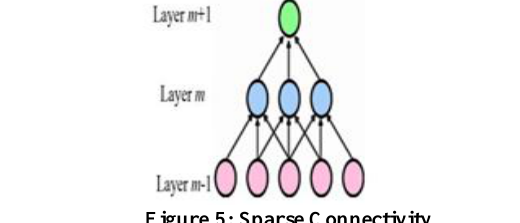
Figure 5: Sparse Connectivity